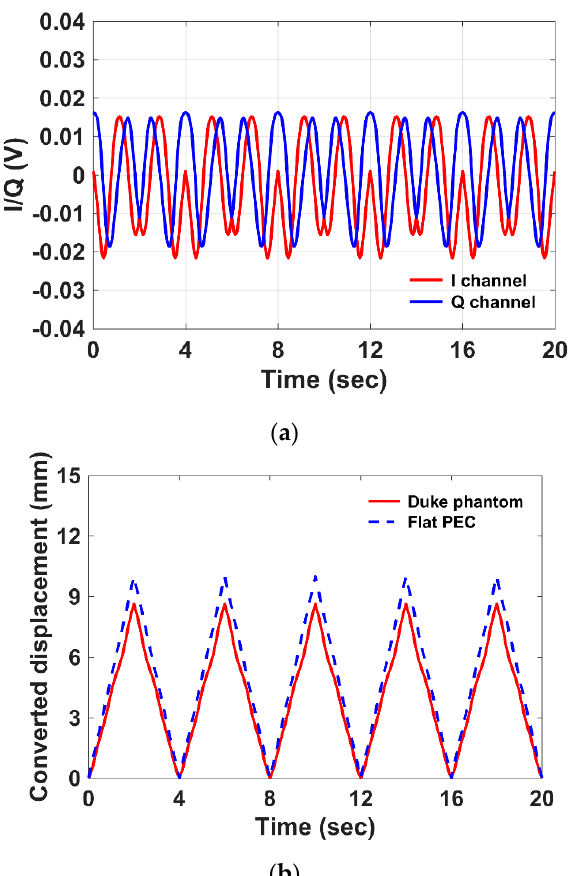
Figure 13. Time-varying I/Q data and arctangent demodulated signals: ( a ) I/Q data for time-varying returned signals; ( b ) converted displacement by arctangent demodulation.